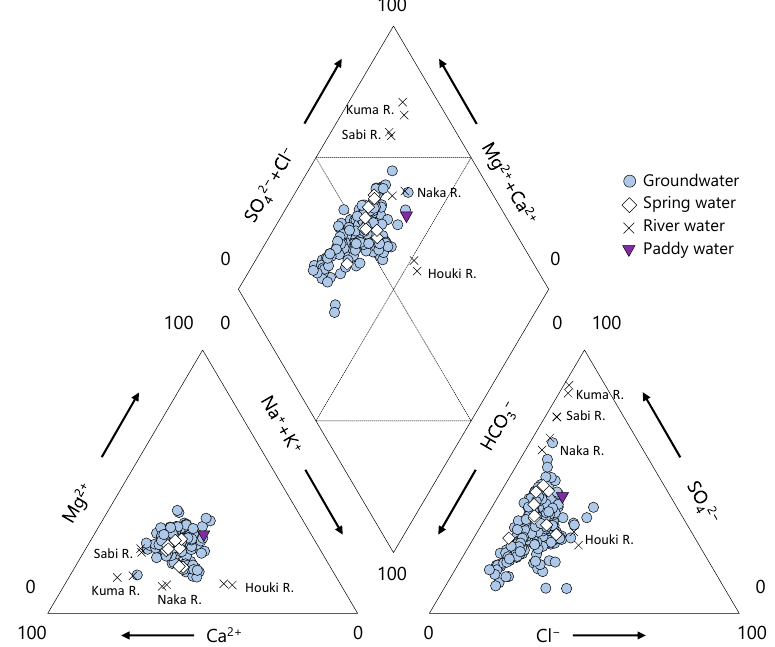
Figure 4. Trilinear diagram of groundwater, spring water, river water, and paddy water.